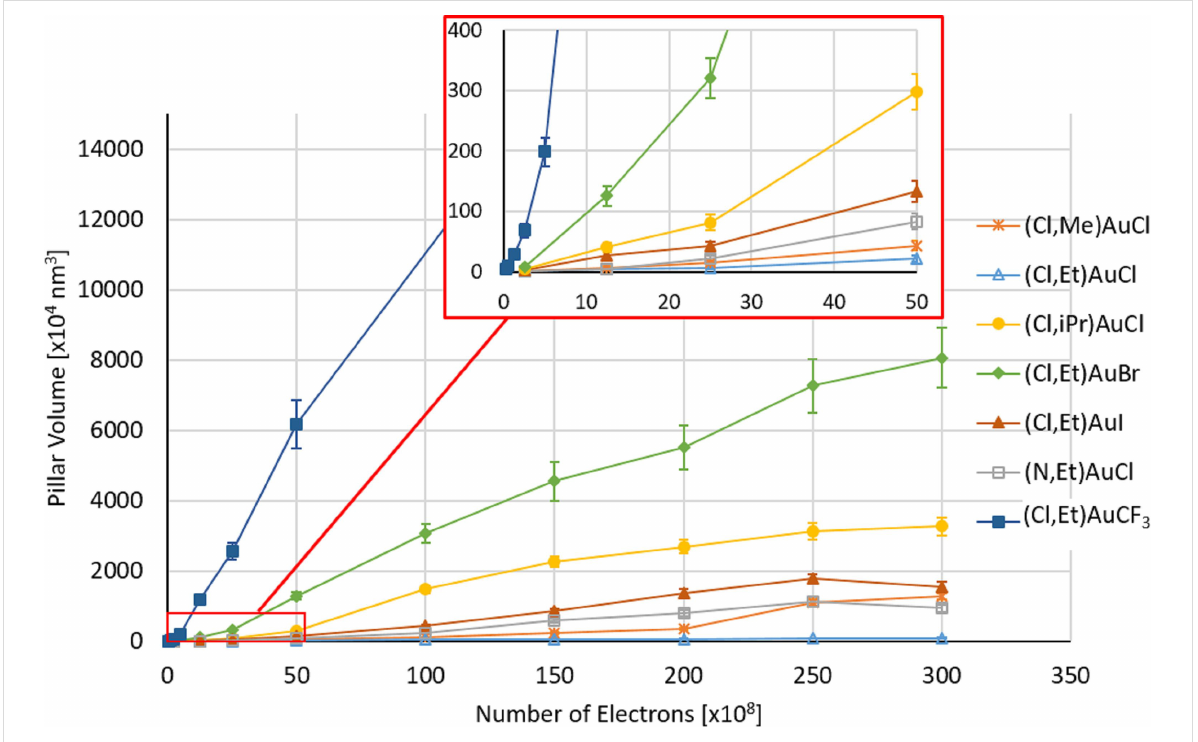
Figure 7: Calculated volume of pillars grown using a 5 kV, 40 pA beam, as a function of the electron dose given as total number of primary electrons used to deposit a pillar. During all experiments the substrate and the precursor were heated together to 100 °C, except for (Cl,Me)AuCl, which was heated to 120 °C. For each precursor an array of 3 × 3 pillars was deposited. The lines between the points merely serve as a guide to the